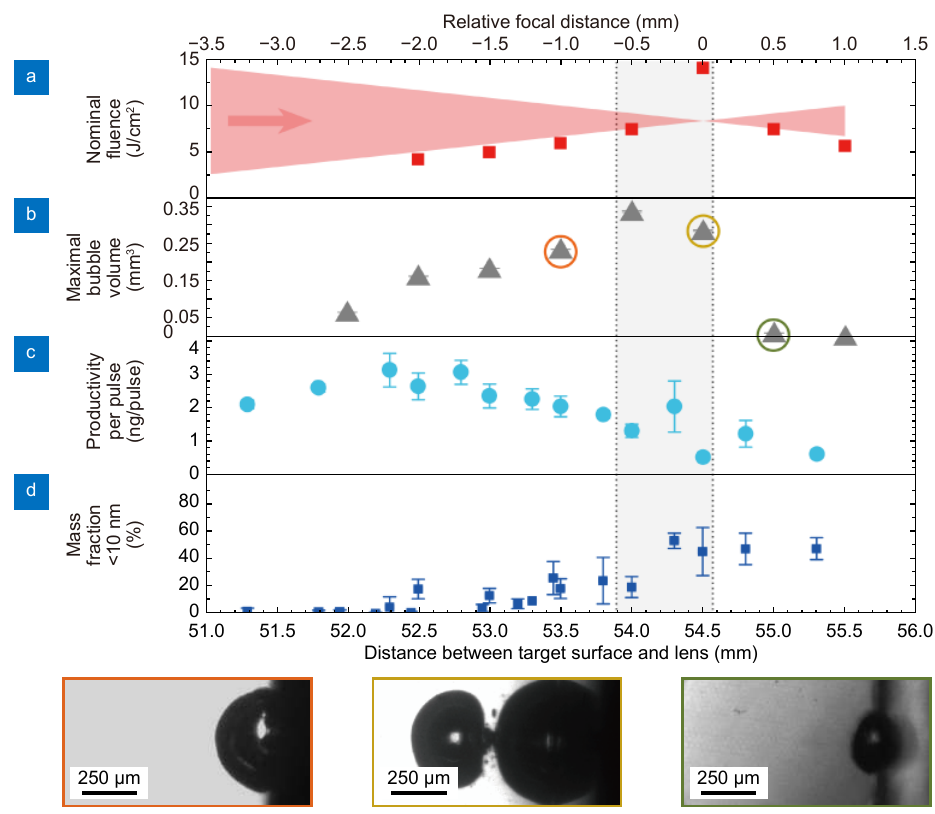
Fig. 3 | The distance between the target surface and the lenses is varied for the 1 ns laser system at maximal laser power, the resulting nominal change in the laser fluence ( a ), the determined maximal cavitation bubble volume ( b ), the corresponding productivity ( c ), and the mass fraction of particles < 10 nm are shown. The gray area in (a) – (d) marks the focal distances where bubble cascades are observed. The exemplary images show bubbles at distances shorter than (orange), within (yellow), and larger (green) than the range where successive bubbles